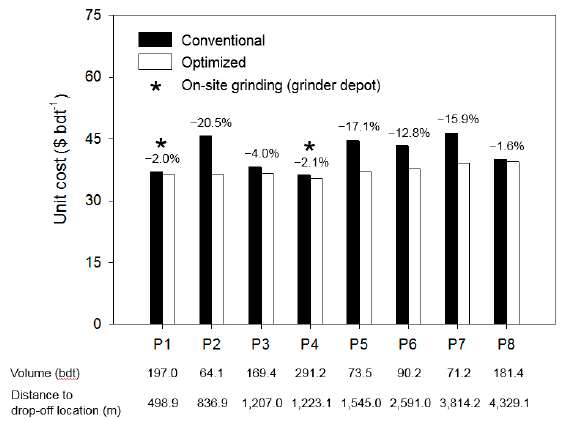
Figure 8. Unit costs of conventional and optimized logistics at each residue pile. The number above the bars indicates the percentage reduction in unit cost per pile attributable to optimized logistics. Table 6. Problem size and solution time of the two model applications presented in this study.